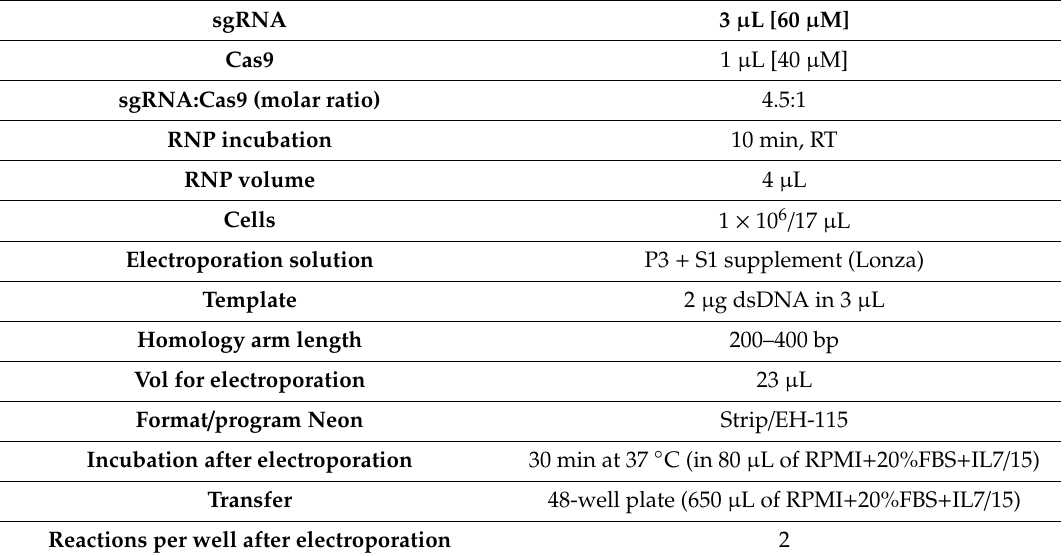
Table 1. Electroporation checklist for large gene knock-in in human T cells.